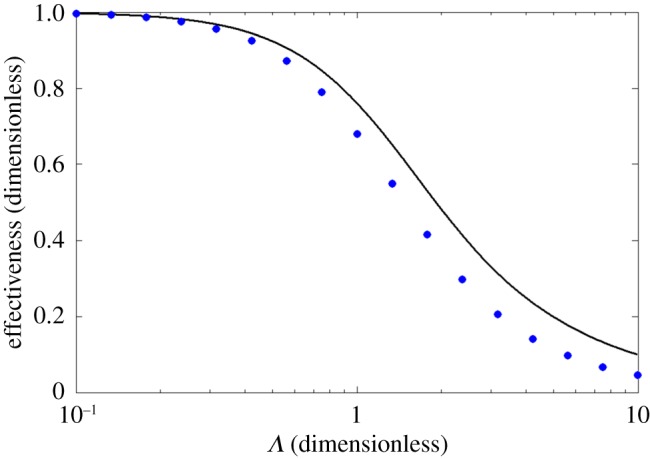
Comparison of first order Taylor series solutions of the system (equation (4.1)) for the thermal effectiveness ε : equations ((4.6) ≡ (A.8)) for plug flow is plotted as a solid black line; overlying this is a sequence of blue dots generated for discrete values of Λ: these data, for Hagen–Poiseuille flow, were obtained using the wholly numerical FDTD method described in appendix B. For Λ ≤ 1, the two treatments yield similar results.